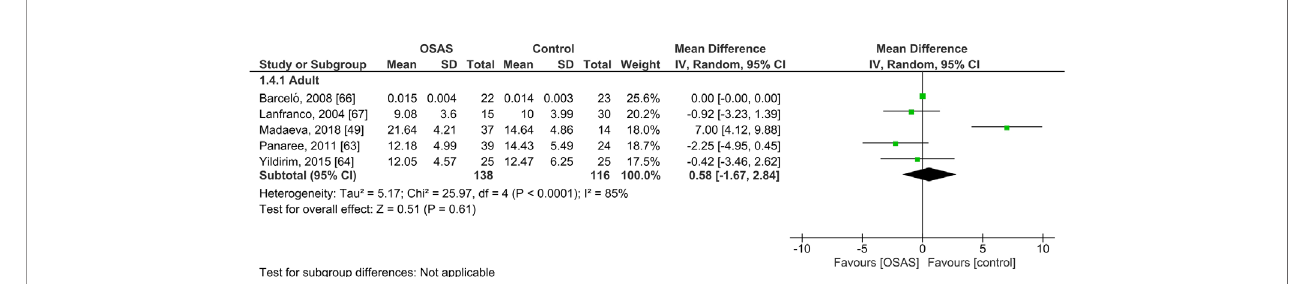
FIGURE 3 | Forest plot of random-effects analysis of serum cortisol levels in adult obstructive sleep apnea syndrome (OSAS) versus the control group. The diamond shape indicates the pooled mean difference (MD). Each black box represents a point estimate of each study and also gives a representation of the study size (the bigger the box, the more participants in the study). A horizontal line representing the 95% con fi dence intervals (CIs) of the study result, with each end of the line representing the boundaries of CI. SD,